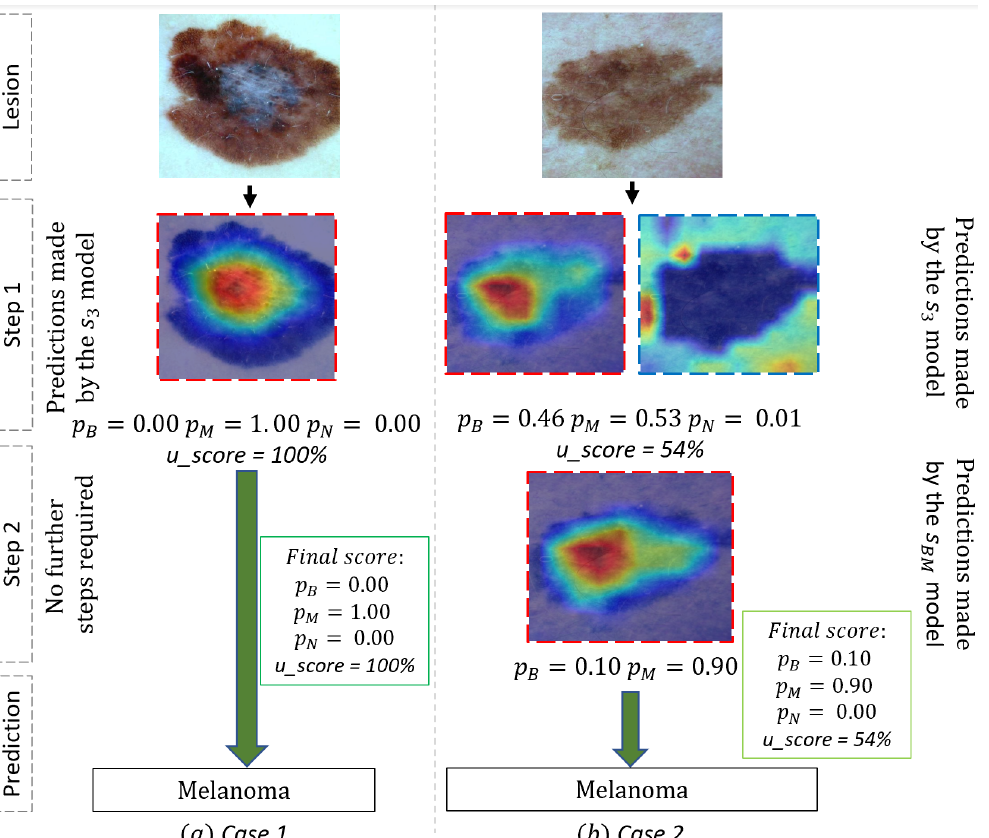
Figure 2. Use cases of our CAD system for classification of Melanoma (M), Nevi (N) and benign Keratosis (B) illustrated by two examples. The dermoscopic image of Lesion 1 represents a